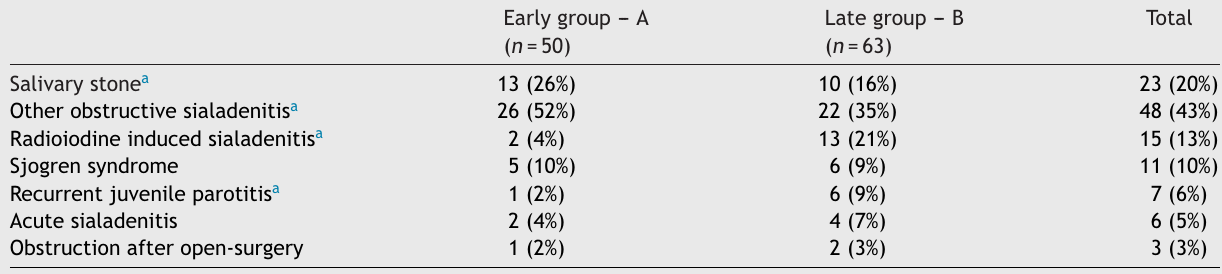
Sialendoscopy indications of early and late groups of sialendoscopy experience.